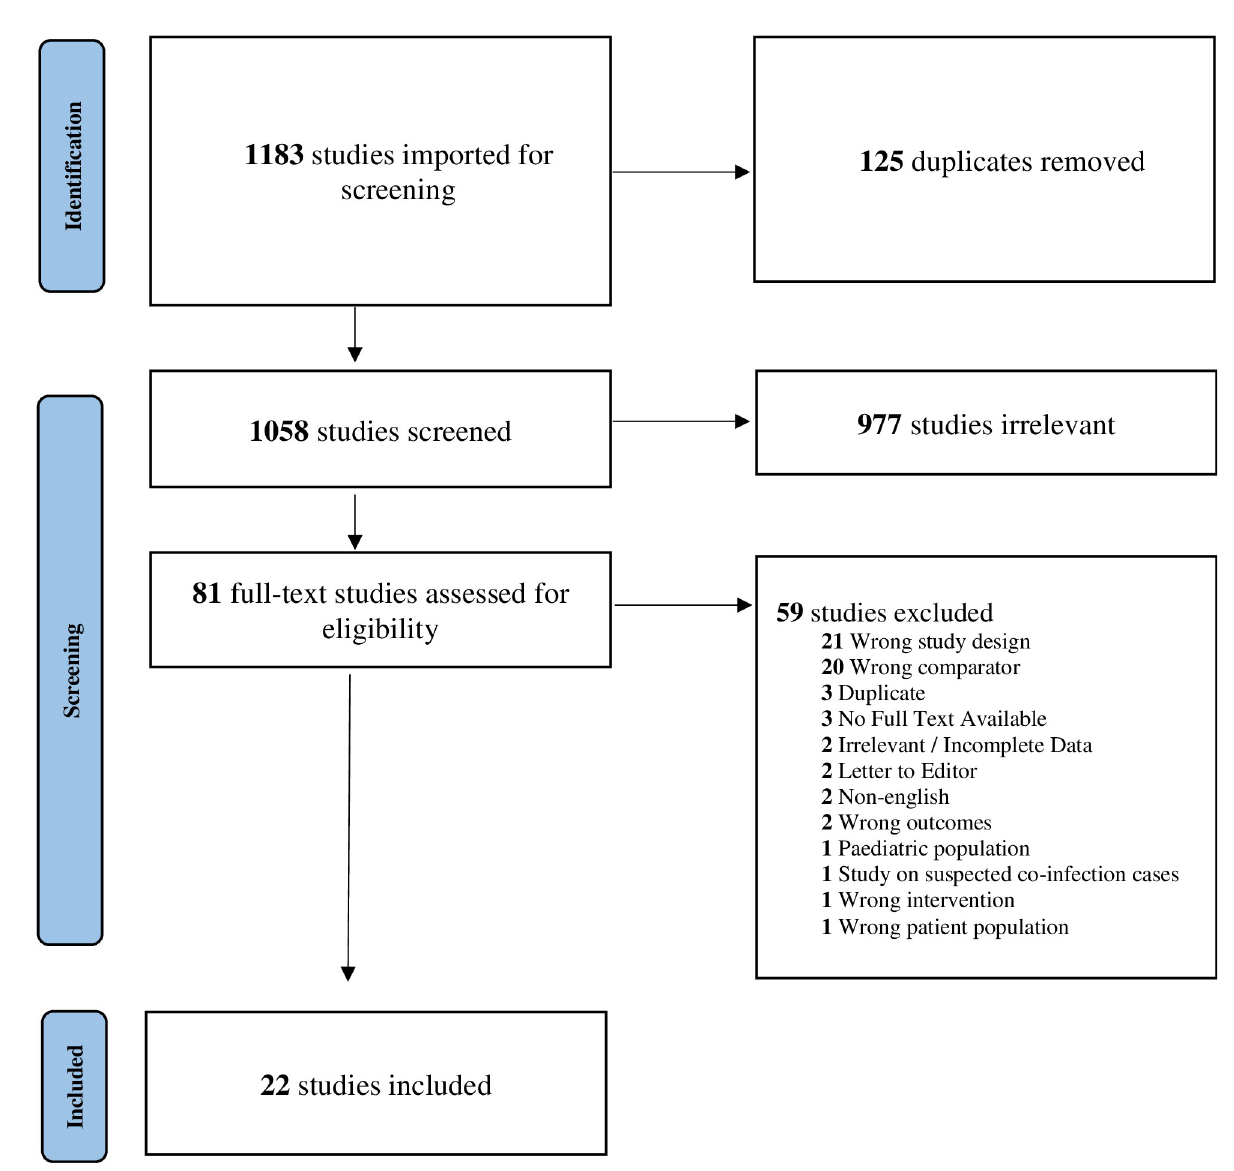
Fig 1. Study flow diagram based on PRISMA